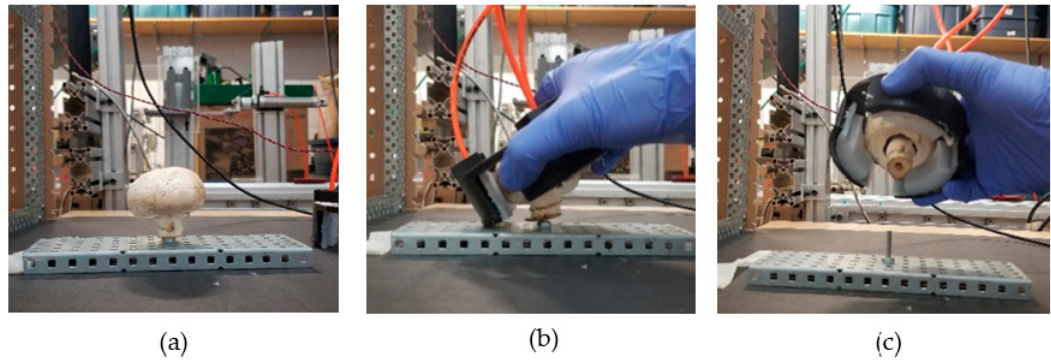
Figure 11. Experimental setup and manual test procedure. ( a ) Organic test object (i.e., mushroom) embedded on threaded rod; ( b ) gripper placed over mushroom; ( c ) gripper lifting mushroom from threaded rod.